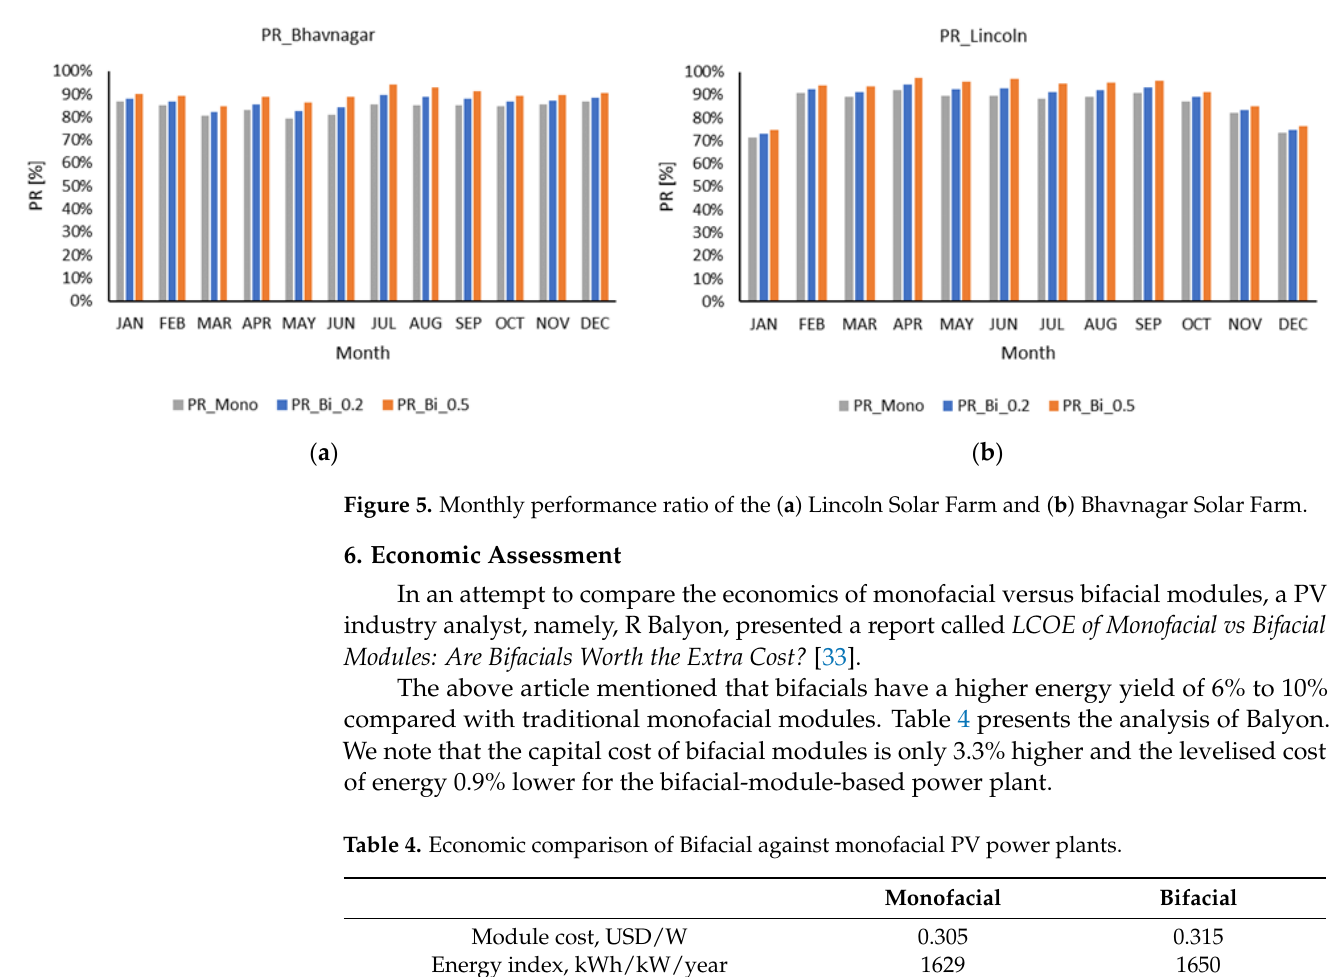
Figure 4. Monthly energy generation of the ( a ) Lincoln Solar Farm and ( b ) Bhavnagar Solar Farm.